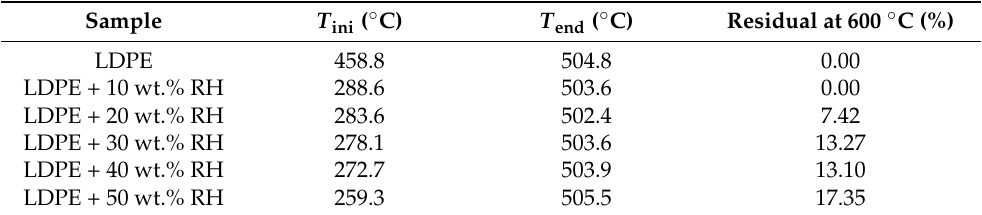
Table 4. TGA results for the neat LDPE and LDPE/RH biocomposites.